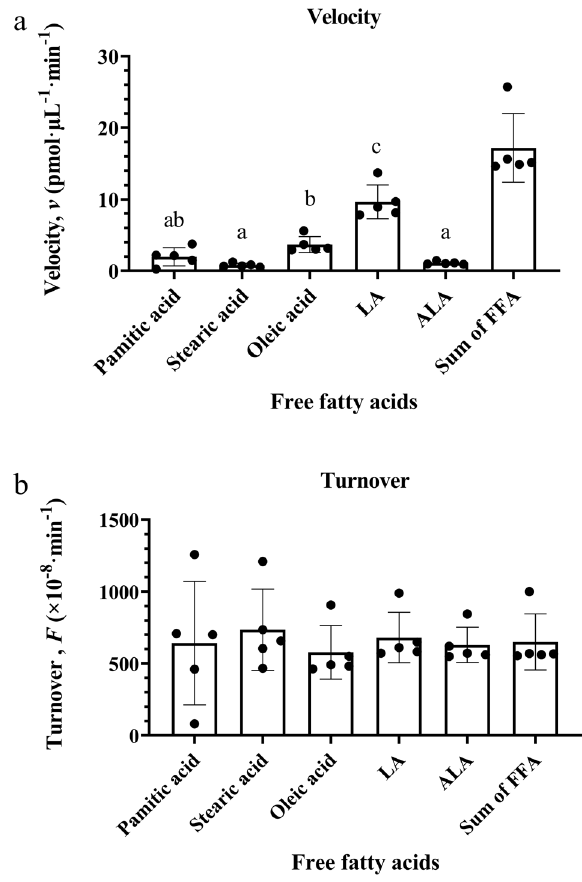
Fig. 3 Velocity and turnover of free palmitic acid, stearic acid, oleic acid, linoleic acid (LA), and α -linolenic acid (ALA) hydrolysis in soybean oil heated for 24 h. Velocity ( a ) and turnover ( b ) data are expressed at mean ± SD of n = 5 per fatty acid. Different superscript letters are signi fi cantly different by one-way ANOVA followed by Tukey ’ s post-hoc test ( p < 0.05). FFA, free fatty